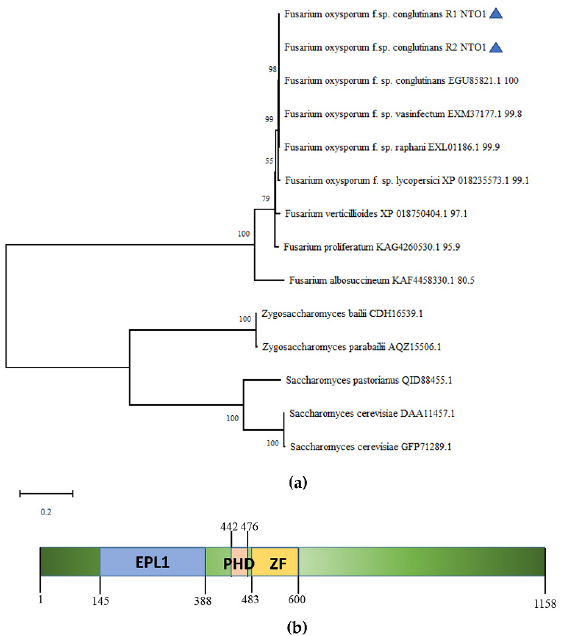
Figure 1. Phylogenetic relationship and structural domain analysis of Nto1. ( a ) Phylogenetic rela- tionship of the Nto1 homologs from different fungal species. Races R1 and R2 are marked with blue triangles; ( b ) conserved domains of Nto1 in F. oxysporum f. sp. conglutinans based on Pfam analysis.